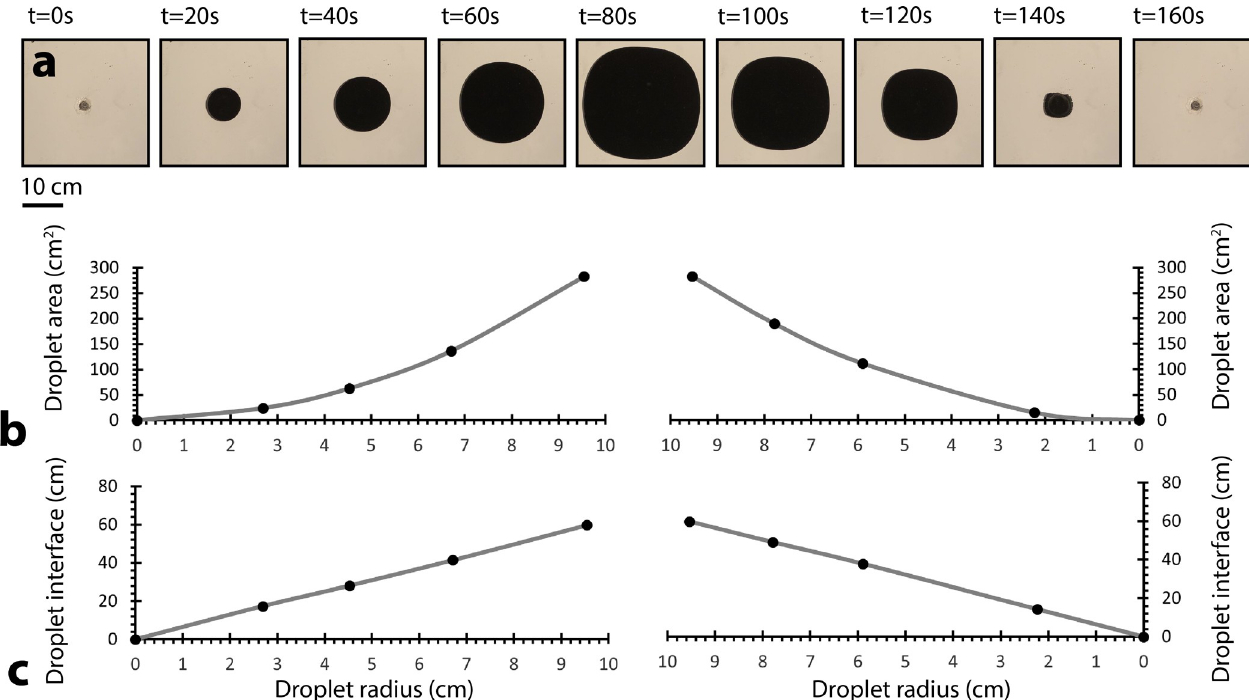
Fig 2. (a) Reversible pigment droplet dispersal and retraction under quasi-isotropic flow field. Images show fifth dispersal/retraction sequence of fifty similar sequences. (b) Droplet area as a function of droplet radius, where droplet area is proportional to dispersed volume, for reversible droplet dispersal and retraction sequence. (c) Droplet interface (perimeter) as a function of droplet radius for reversible droplet dispersal and retraction sequence.